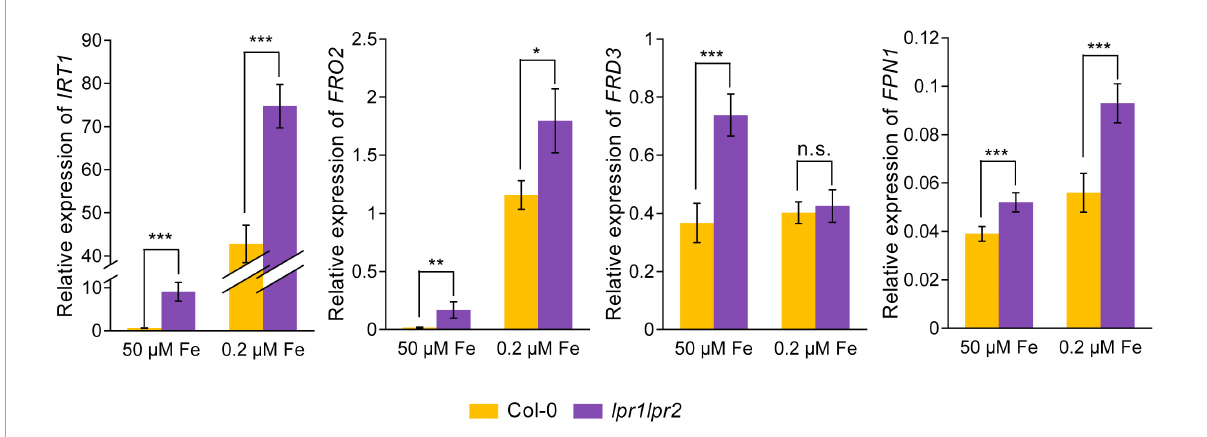
FIGURE7 Altered expression of Fe homeostasis-related genes in roots of lpr1lpr2 double mutant. The expression of IRT1 , FRO2 , FRD3 , and FPN1 in roots of Col-0 and lpr1lpr2 . The plants were precultured in low-Fe (0.2 µ M) nutrient solution for 3 weeks and then treated with sufficient Fe (50 µ M) or low-Fe (0.2 µ M) for 4 days. EF1 α and UBQ10 were used as the internal control. Values are means ± SD of four replicates. Asterisks indicate a significant difference at * P < 0.05, ** P < 0.01, *** P < 0.001 by Tukey’s